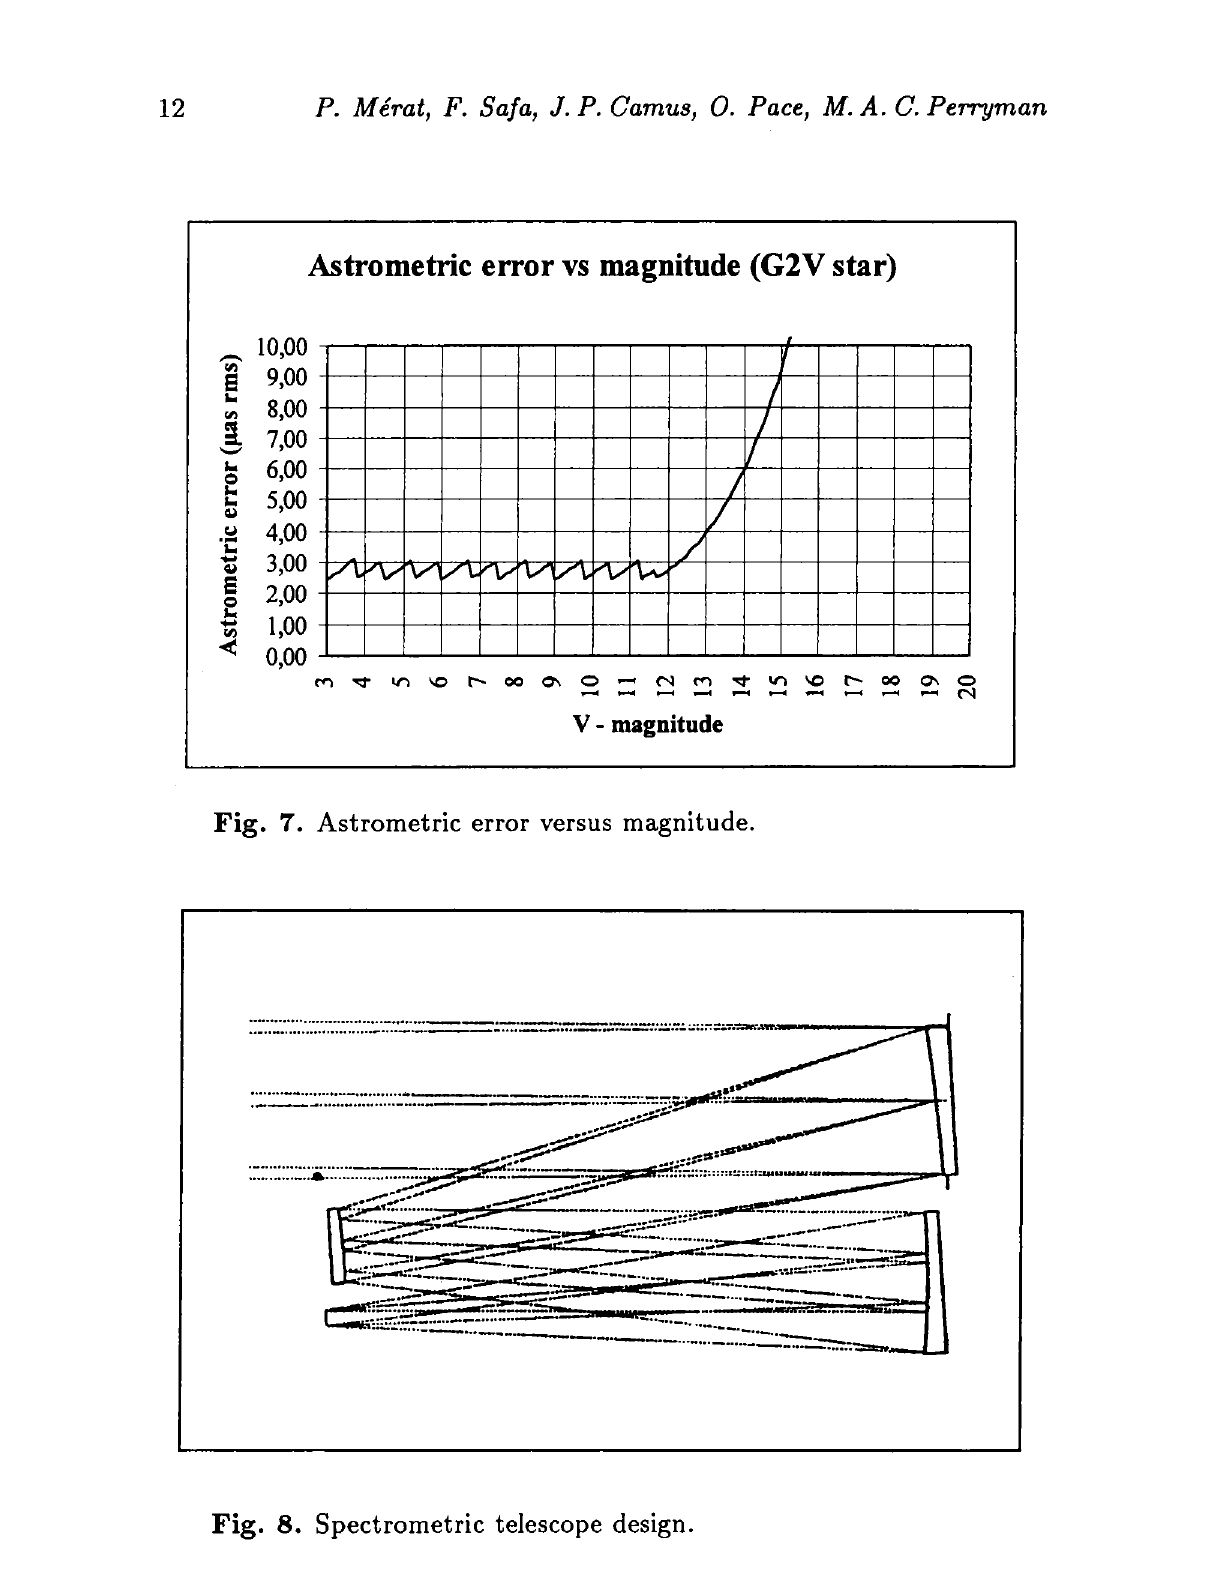
Fig. 8. Spectrometric telescope